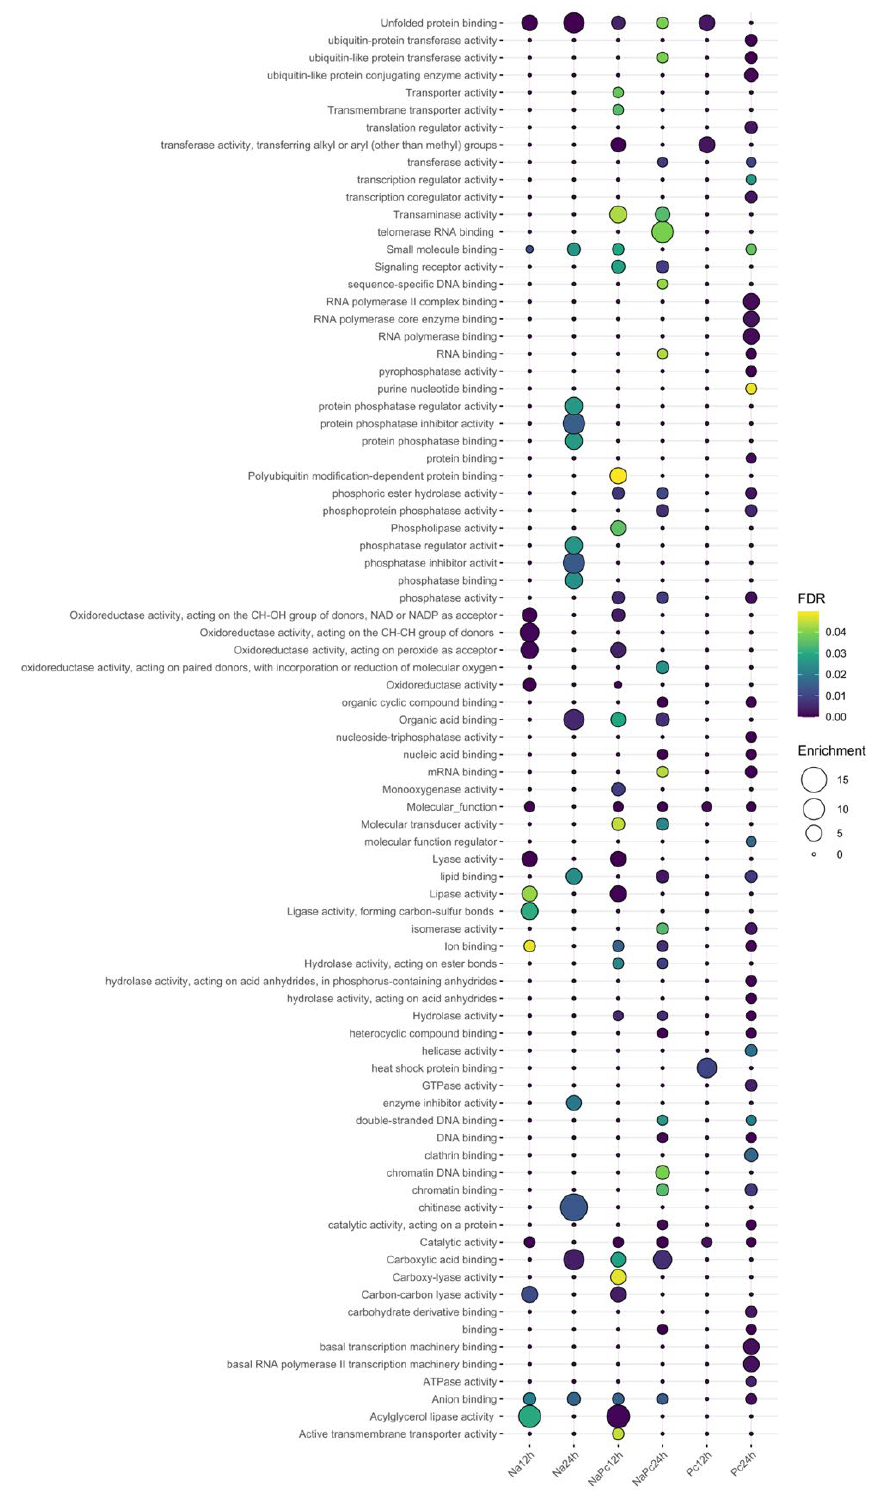
Figure 5. GO enrichment analysis from top 25 upregulated genes. FDR analysis in yellow/purple gradient being darker closer to 0. Fold enrichment (bubble size) is assigned to each KEGG pathway. p < 0.05.